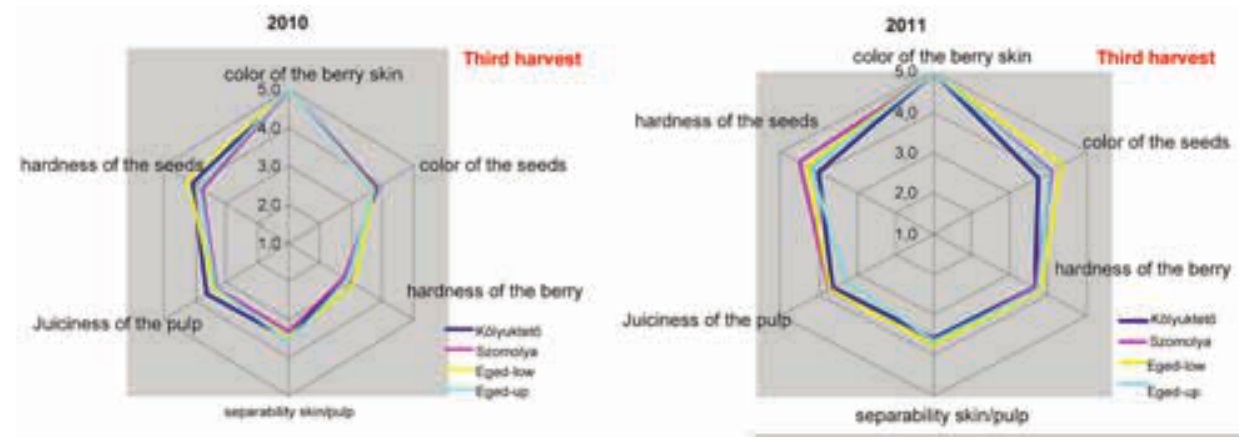
Figure 3 c: Main physical parameters of the berry (2010-2011-Third harvest time)